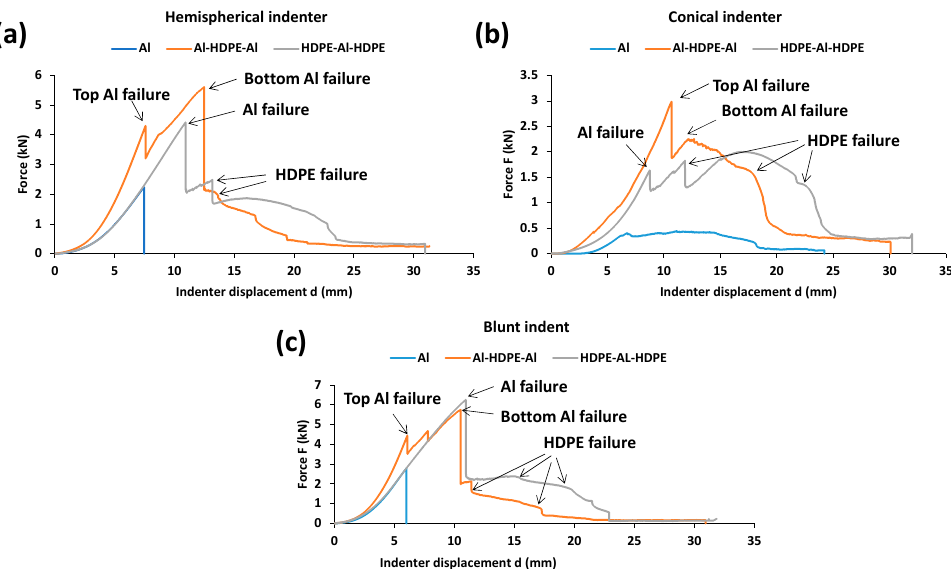
Figure 11. Quasi-static force and displacement profiles of trilayer laminates under the ( a ) hemispherical, ( b ) conical and ( c ) blunt indenters.